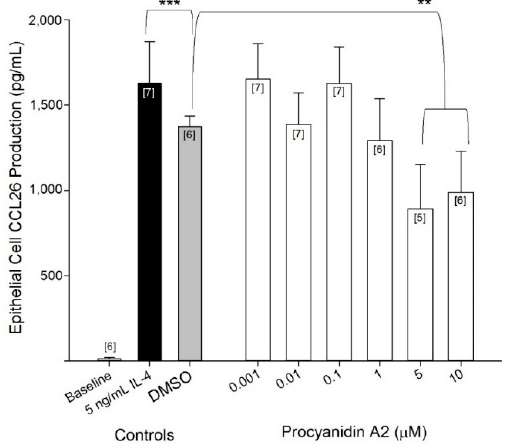
Figure 4. Procyanidin A2 inhibits IL-4-stimulated CCL26 production. A549 cells were seeded at 5 × 10 5 in 12-well plates, serum starved for 24 h and incubated with control DMSO or a range of procyanidin A2 concentrations for 6 h, washed and then stimulated with 5 ng/mL IL-4 for 24 h. Collected supernatants were measured for CCL26 by ELISA. The results are expressed as mean ± SEM, which were from 5–7 separate experiments and 15–21 individual measurements. Brackets, [ n ], indicate number of experiments for each data point. ** p < 0.01, *** p < 0.001.